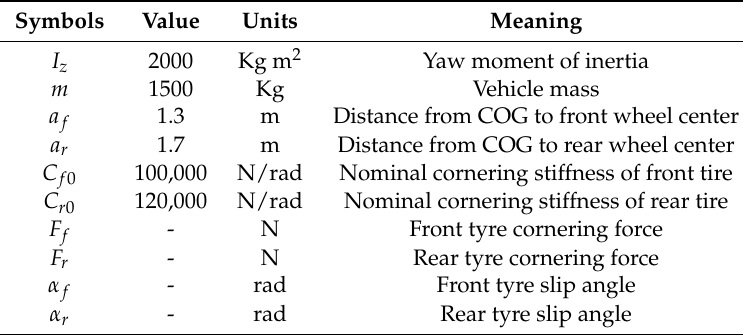
Table 1. Vehicle